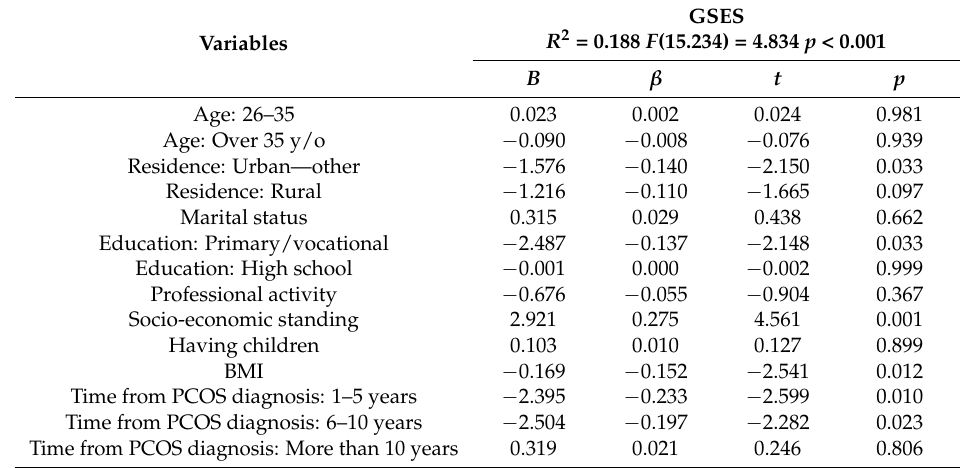
Table 3. Regression model for variables